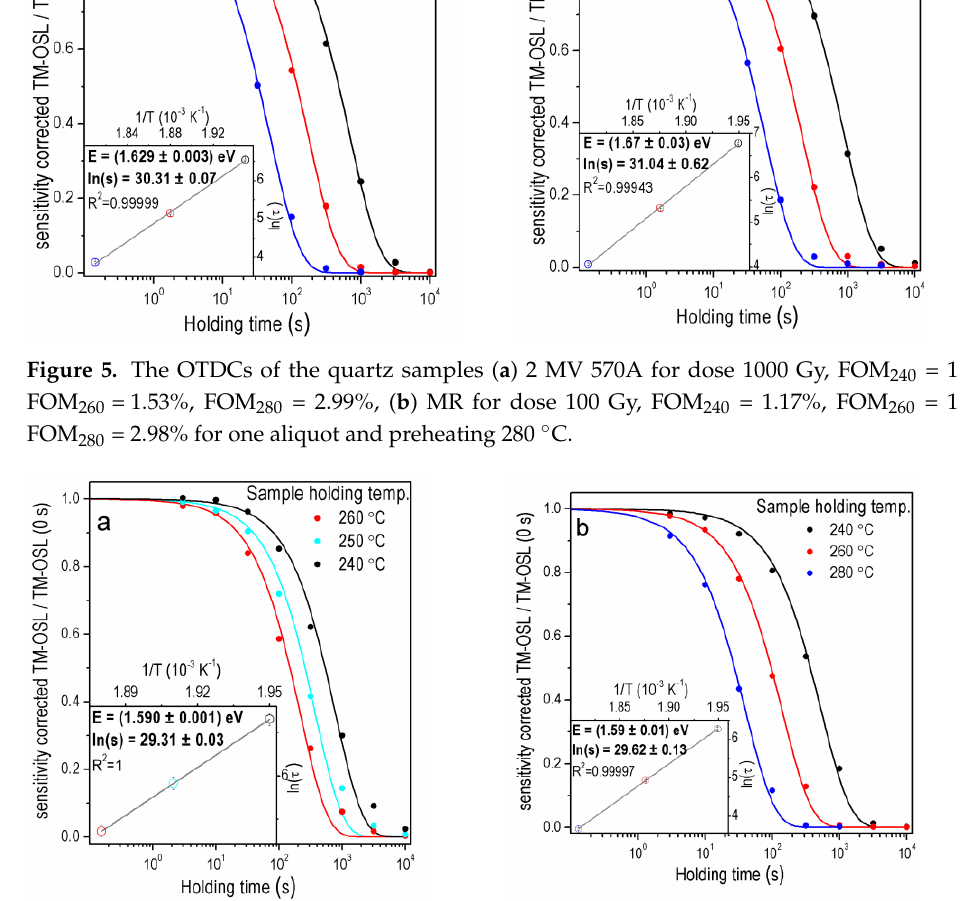
Figure 6. The OTDCs of the granite samples ( a ) Catalina FOM 240 = 4.46% FOM 250 = 4.70% FOM 260 = 5.23% ( b ) Oracle FOM 280 = 3.57% FOM 260 = 1.90% FOM 240 = 2.72% for one aliquot after dose 1000 Gy and preheating 280 °C.